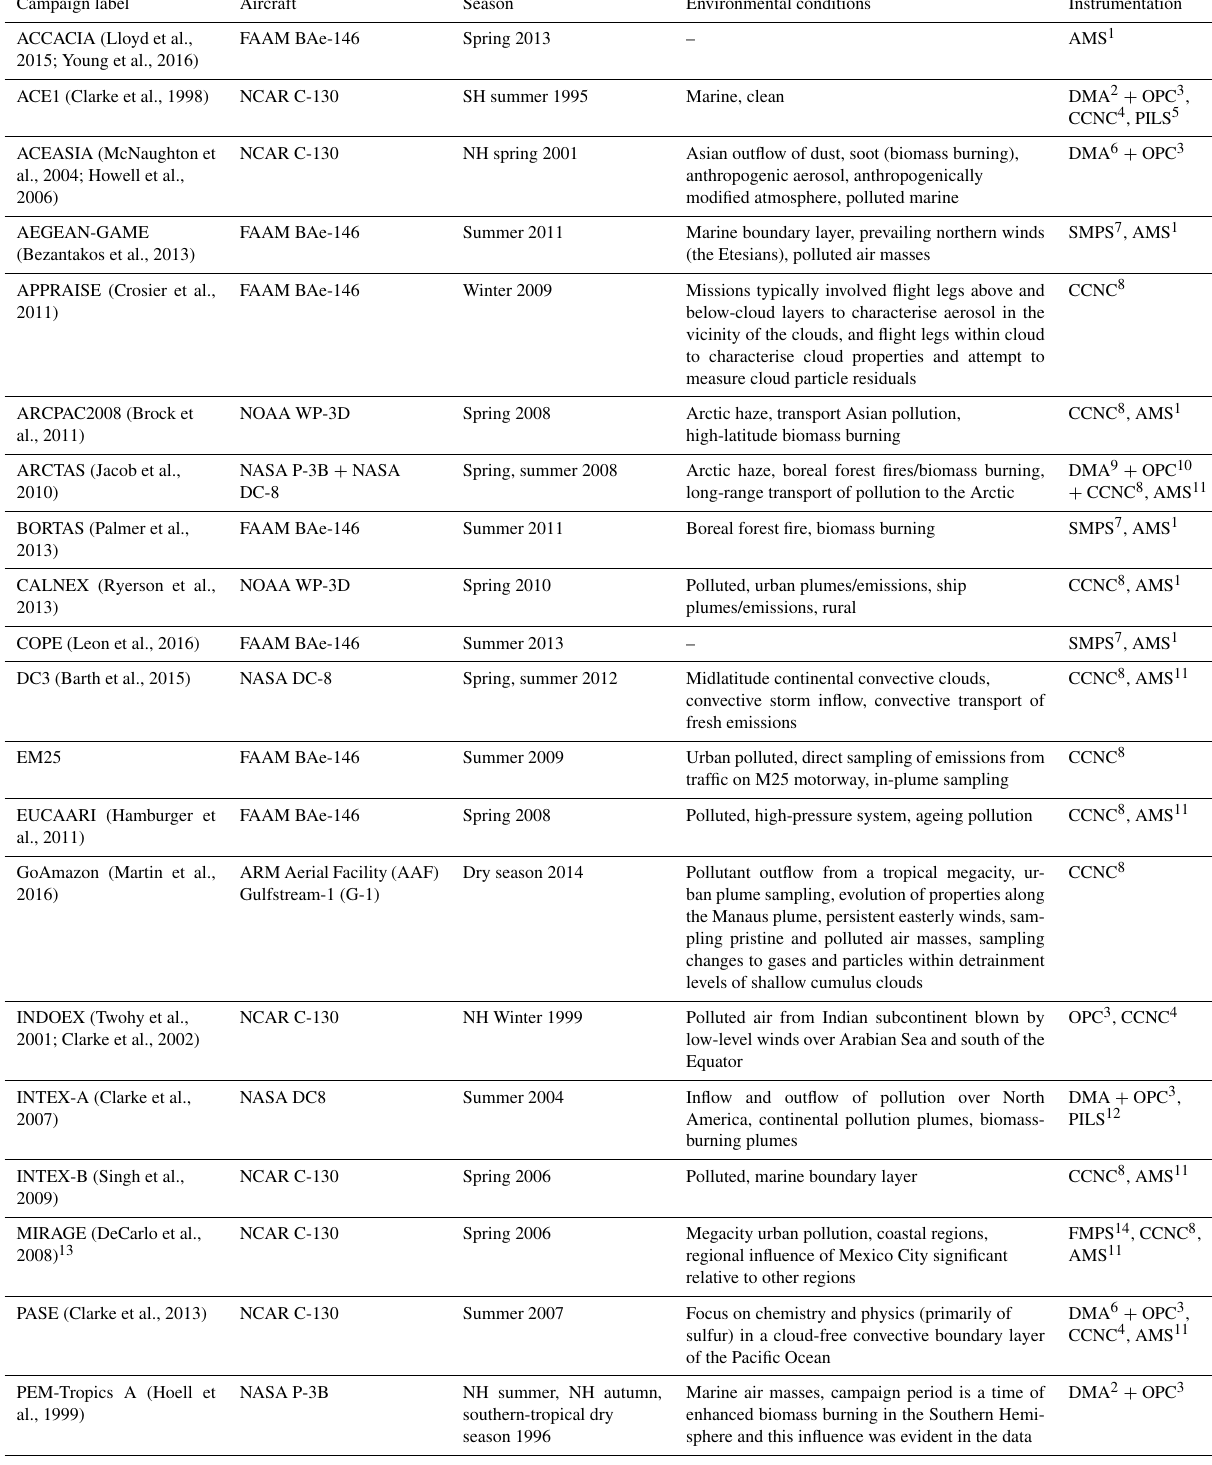
Table 1. Details of the campaigns and instruments included in the GASSP database that were used in this analysis. The environmental conditions summarise the prevailing conditions during the measurements; see associated references for more